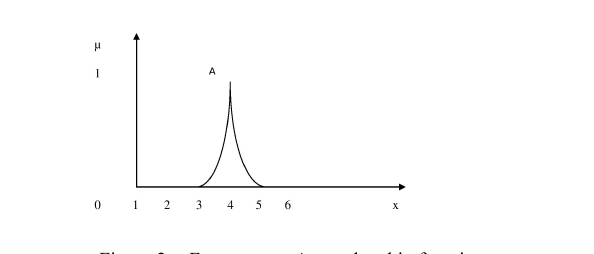
Figure 2. Fuzzy group A membership function.